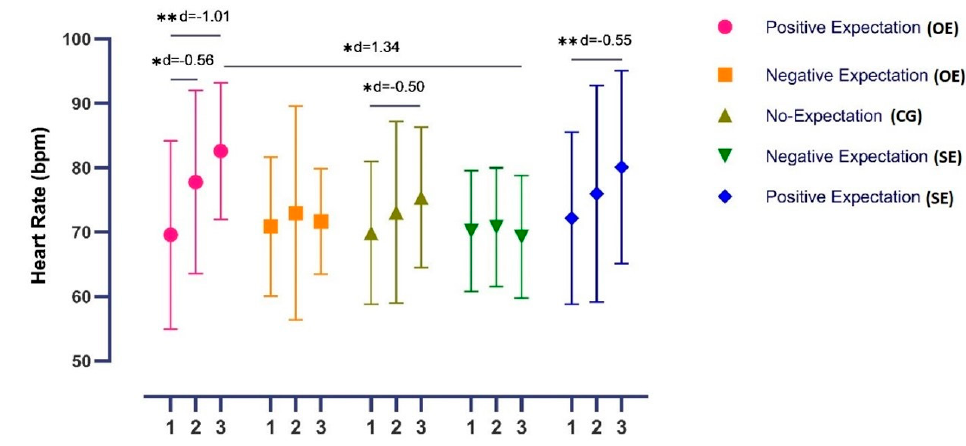
Figure 4. Differences in heart rate between groups and time–group interaction, * p < 0.05, ** p < 0.001.